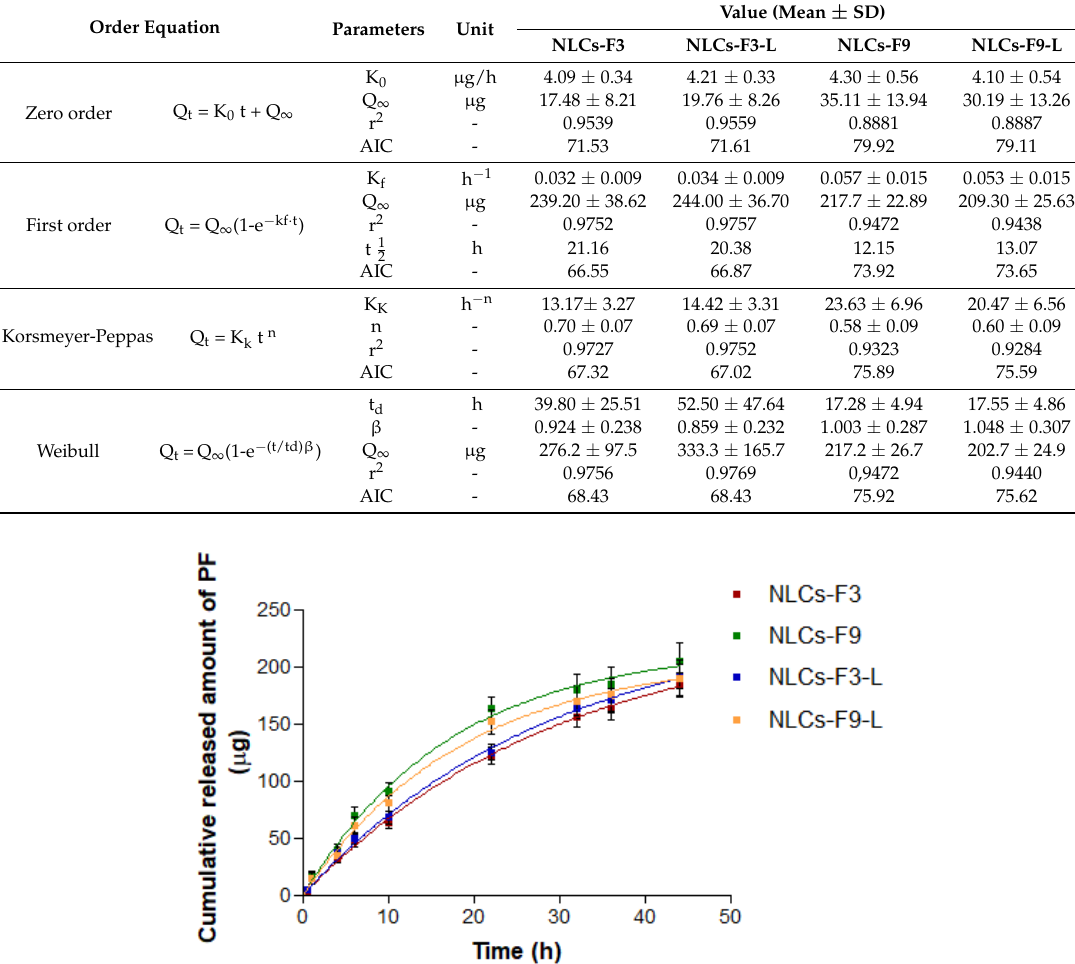
Table 3. In vitro release profiles. Mean parameters obtained after fitting the release data from NLCs-F3, NLCsF3-L, NLCs-F9, and NLCs-F9-L (mean ± SD, n = 3) to different Kinetic model equations.